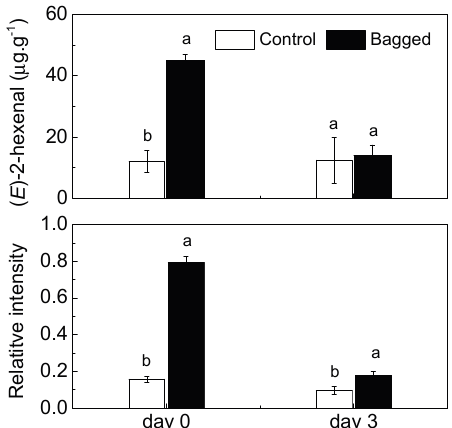
Figure 1. Changes in ( E )-2-hexenal contents and PpHPL1 expressions of peach fruit skin during postharvest ripening (2011 fruit season). Each value represents the mean ± standard error of three replicates. The significant differences are indicated with different letters (LSD,